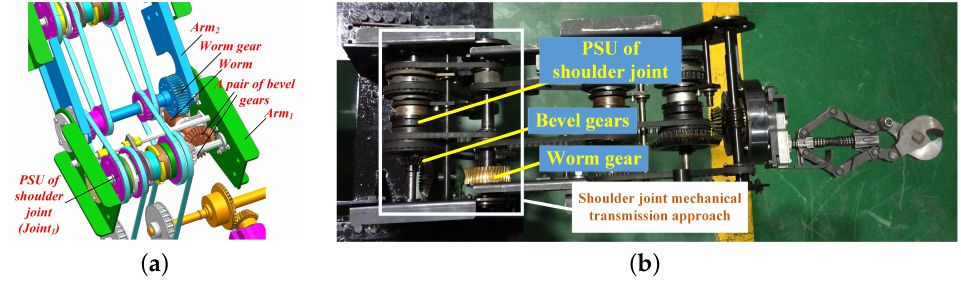
Figure 19. Illustration of the shoulder joint. When the worm is driven by the power motor, the worm gear will be rotated together with the next arm. ( a ) The 3D model of shoulder joint. ( b ) The prototype of shoulder